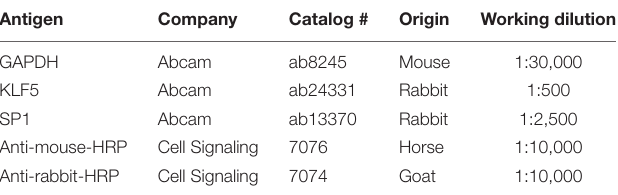
TABLE 3 | Antibodies for Western blot